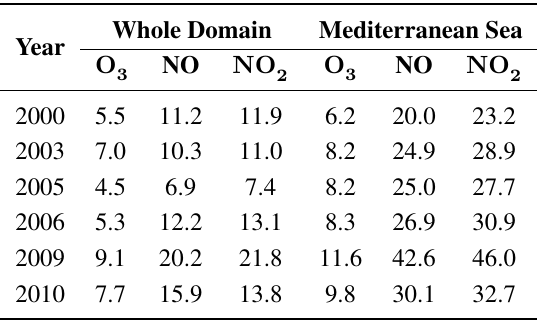
Table 3. The influence (%) of shipping emissions on the average concentrations of O and NO in the first six layers. The values refer to the highest resolution domains (9 km by 2 9 km), calculated as (Tot_Emiss − No_Ships ) / Tot_Emiss × 100 %. Whole Domain Mediterranean Sea Year